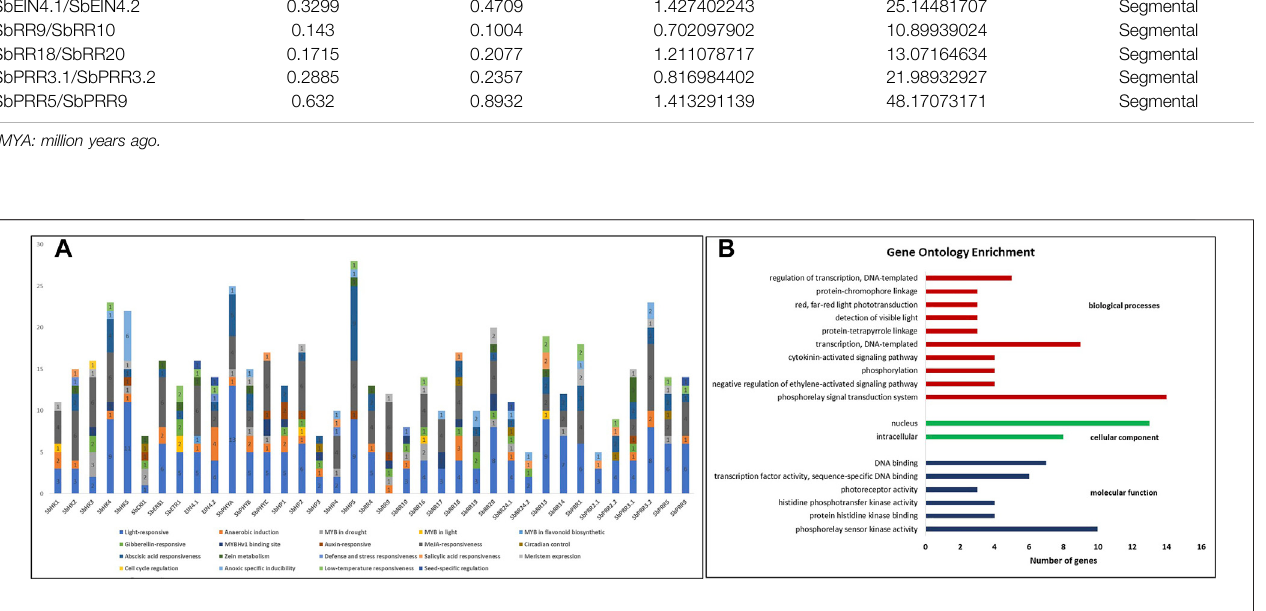
TABLE 3 | Ks, Ka and Ka/Ks calculation and divergence time of the duplicated SbTCS gene pairs. Duplicated gene pairs